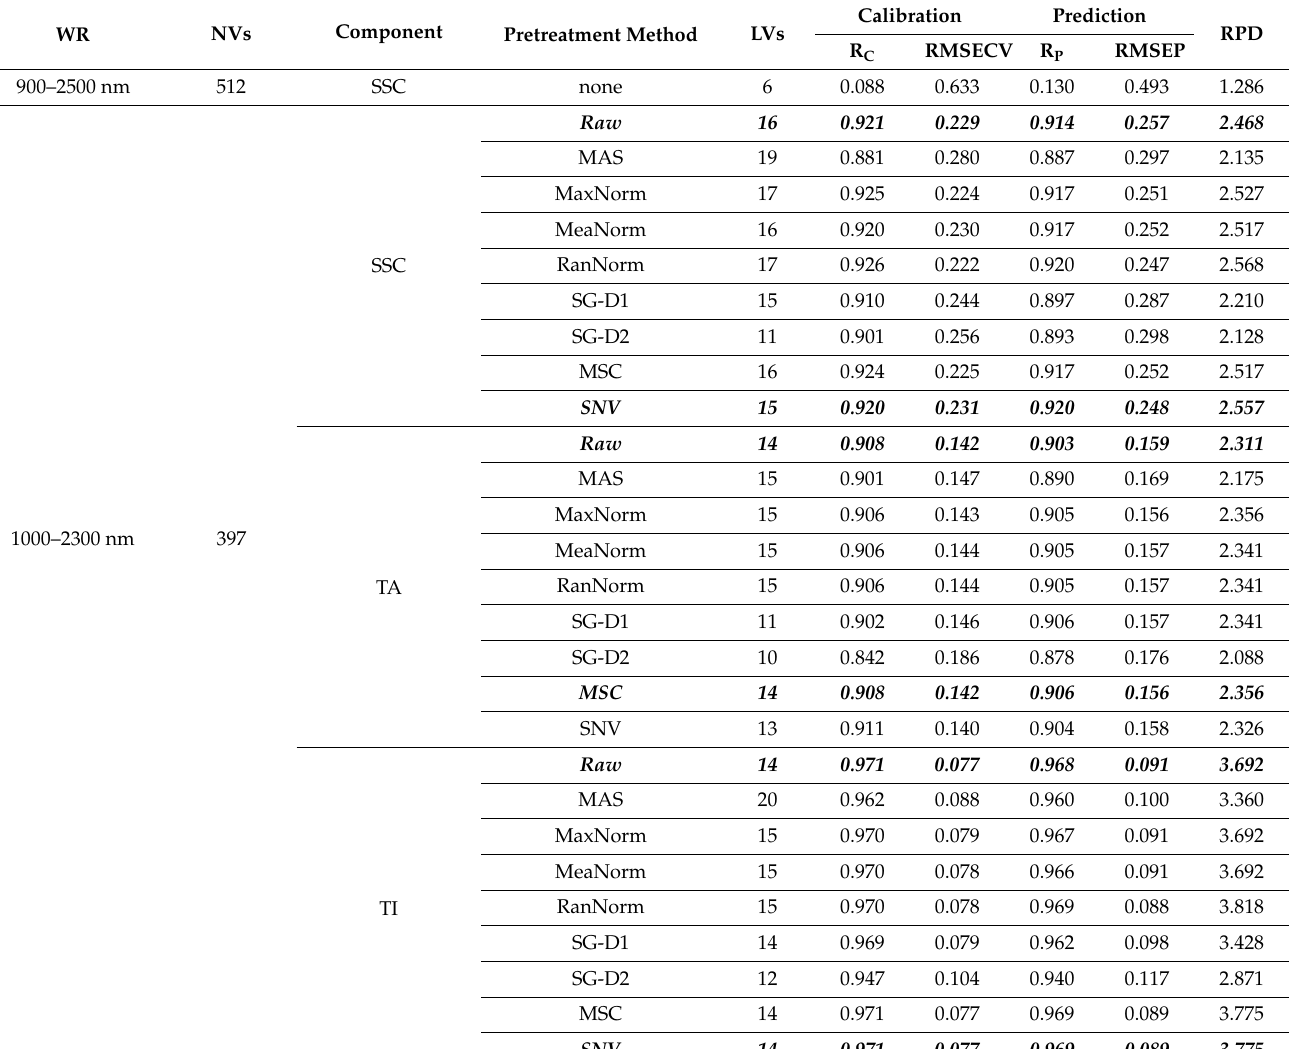
Table 2. The performance of the PLSR model based on the NIR spectra range of 1000–2300 nm preprocessed by different methods for determination of SSC, TA, and TI in pears.